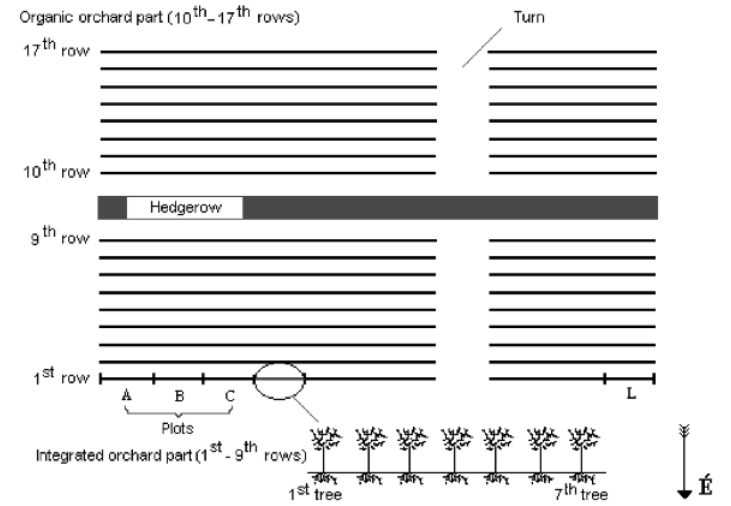
Figure 1 : Field set of examined apple